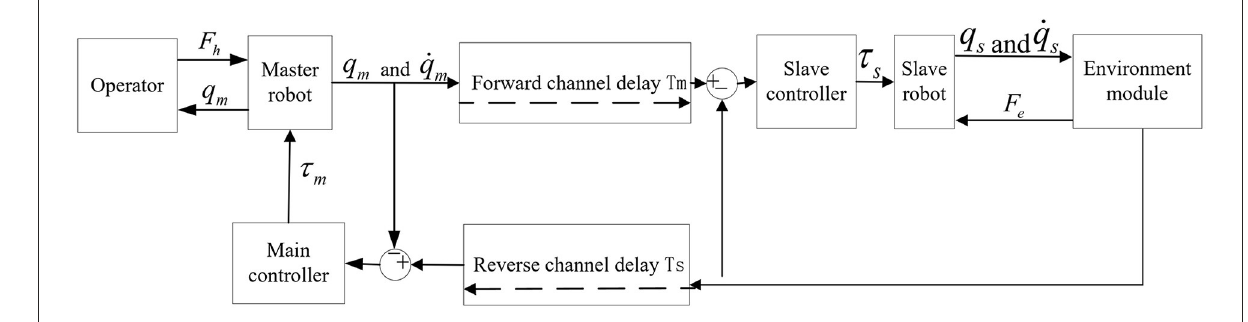
FIGURE1 Control structure diagram of teleoperation robot system based on the position